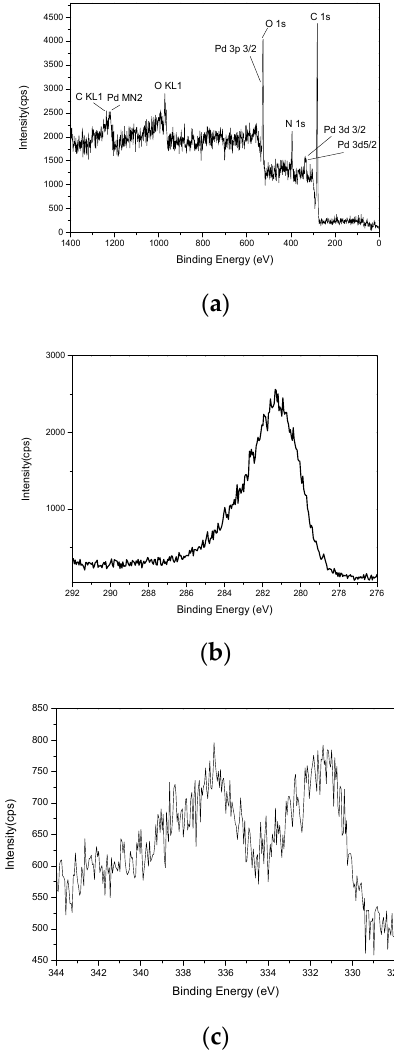
Figure 4. XPS spectra of ( a ) Fe 3 O 4 @NC/Pd catalyst, ( b ) C 1s and ( c ) Pd 3d.